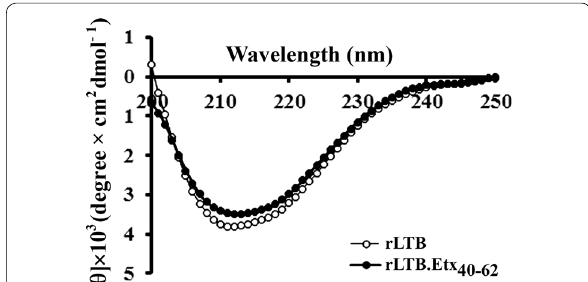
Fig. 2 Secondary structure analysis of rLTB.Etx 40–62 : far UV circular dichroism spectra of the rLTB.Etx 40–62 and rLTB recorded in the wavelength range 200–250 nm are shown. Mean residue mass ellipticity (θ) in units of degree cm 2 dmol − 1 are ×